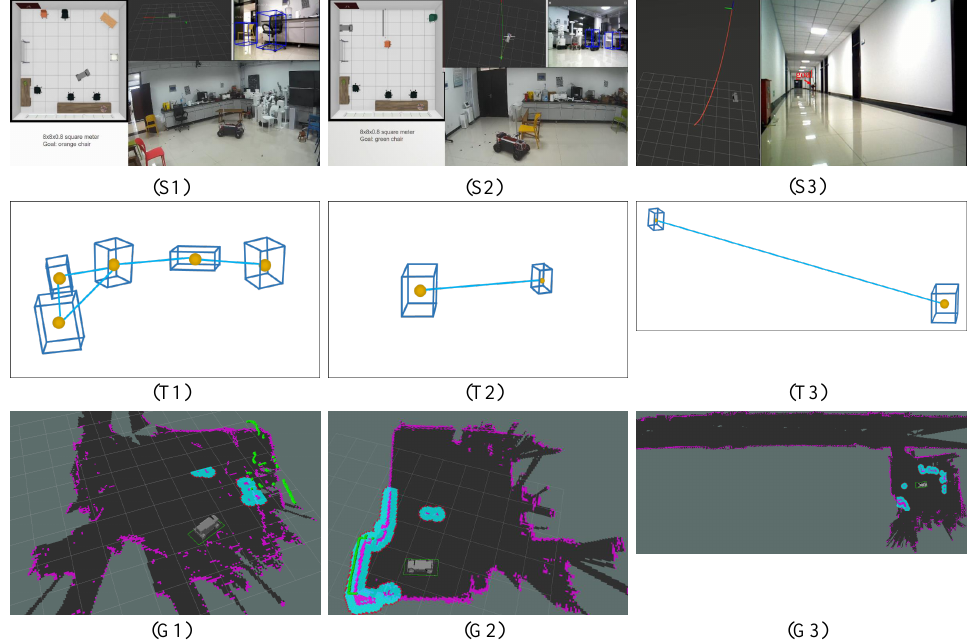
Figure 16. Example of navigation in the real world. ( S1 – S3 ) show the test scenes of our method in the real world. ( T1 – T3 ) correspond to the topological semantic maps of the three scenes, respectively, which are generated by our previous work [13]. ( G1 – G3 ) correspond to the high-precision occupancy grid maps of the three scenes, respectively, which are generated by the OGMADWA